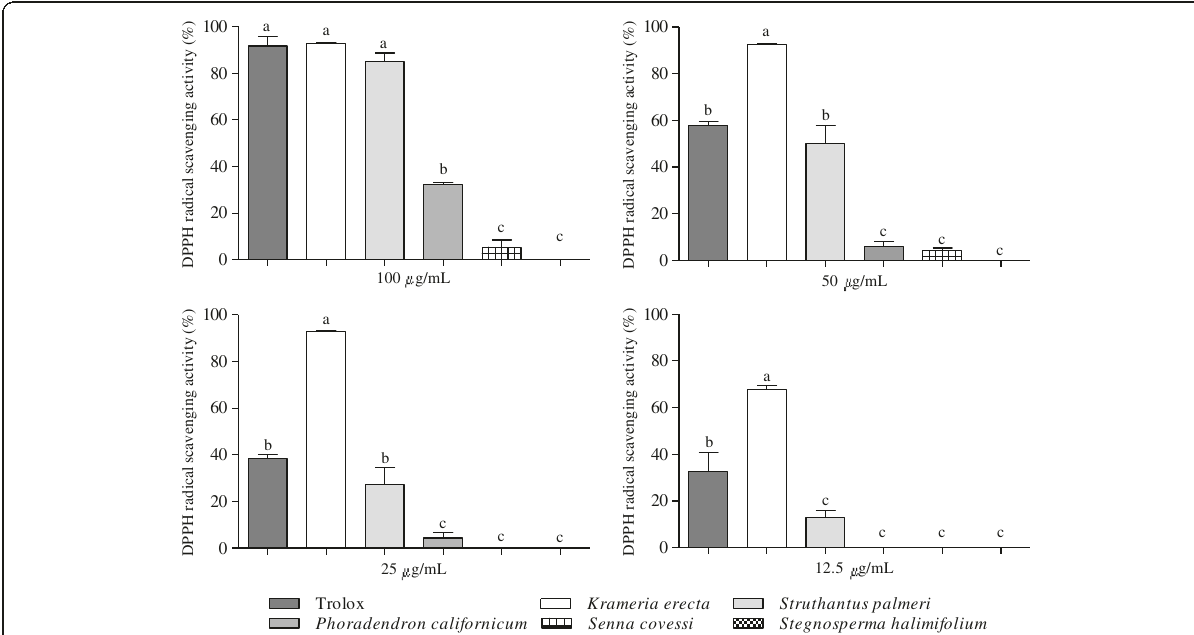
Figure 1 Radical scavenging activity in the DPPH assay of Krameria erecta , Struthanthus palmeri , Phoradendron californicum , Senna covesii and Stegnosperma halimifolium methanolic extracts. Trolox was used as control. The bars represent the standard deviation (mean ± SD; n = 3). Significant differences (p < 0.05) are indicated by different letters (a –